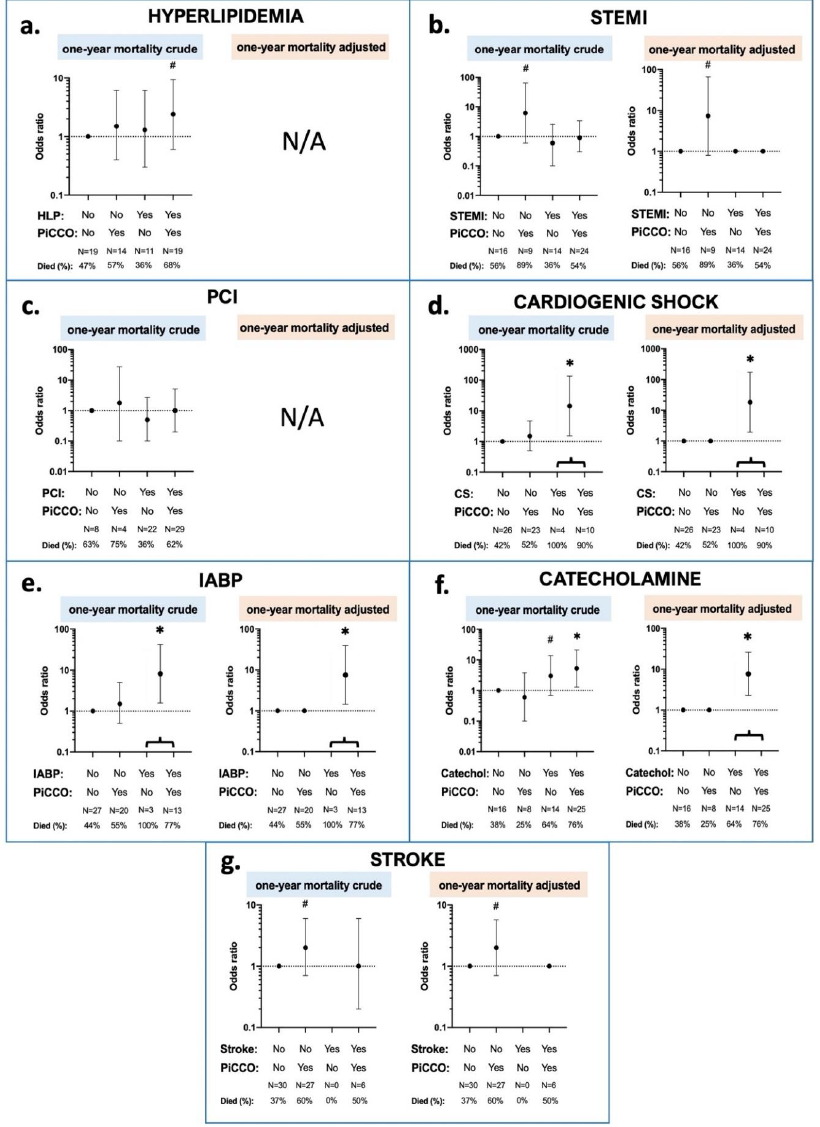
Figure 6. Interaction effects between PiCCO ™ -application, 1 year mortality, and patient condition characteristics. Patient conditions are depicted in the different subfigures; ( a ) hyperlipidemia; ( b ) STEMI at admission; ( c ): PCI treatment; ( d ): cardiogenic shock at admission; ( e ): IABP insertion; ( f ): catecholamine administration; ( g ): stroke in the prior history. Crude and adjusted logistic regressions were performed. In the crude models, all the interaction term dummy variables were included as separate variables. In the adjusted models, non-significant dummies were combined. ∗ : p < 0.05; #: p < 0.2; catechol: catecholamine; CS: cardiogenic shock; HLP: hyperlipidemia; IABP: intra-aortic balloon pump; N: number of patients; PCI: percutaneous coronary intervention; PiCCO: pulse index contour cardiac output; and STEMI: ST-elevation myocardial